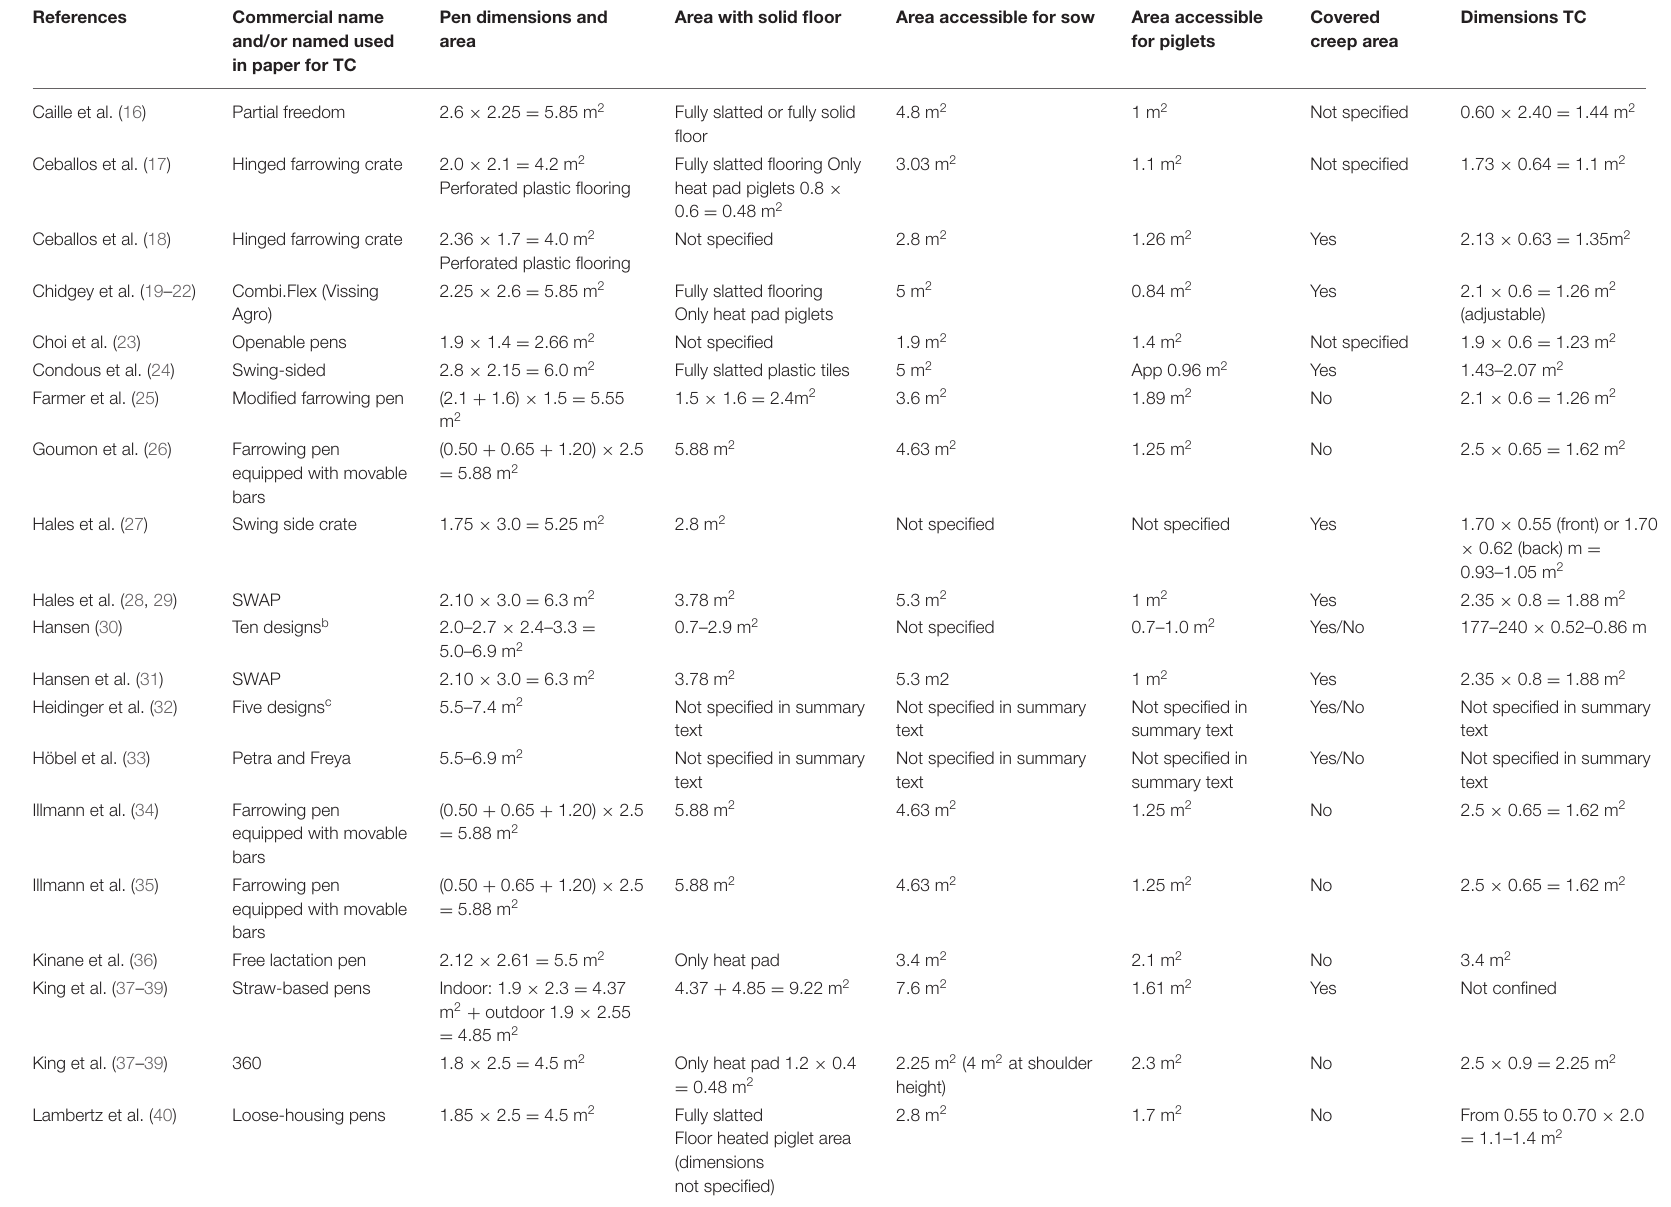
TABLE 2 | Pen dimensions a and area (total, solid floor, accessible for sows, only accessible for piglets) and presence of covered creep